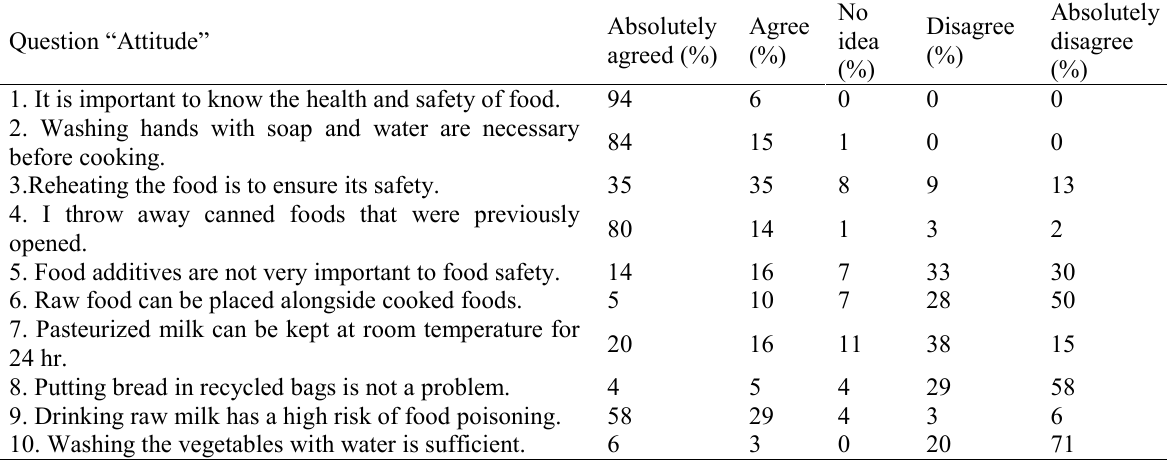
Table 4. Respondents' food sanitation and safety attitude Question